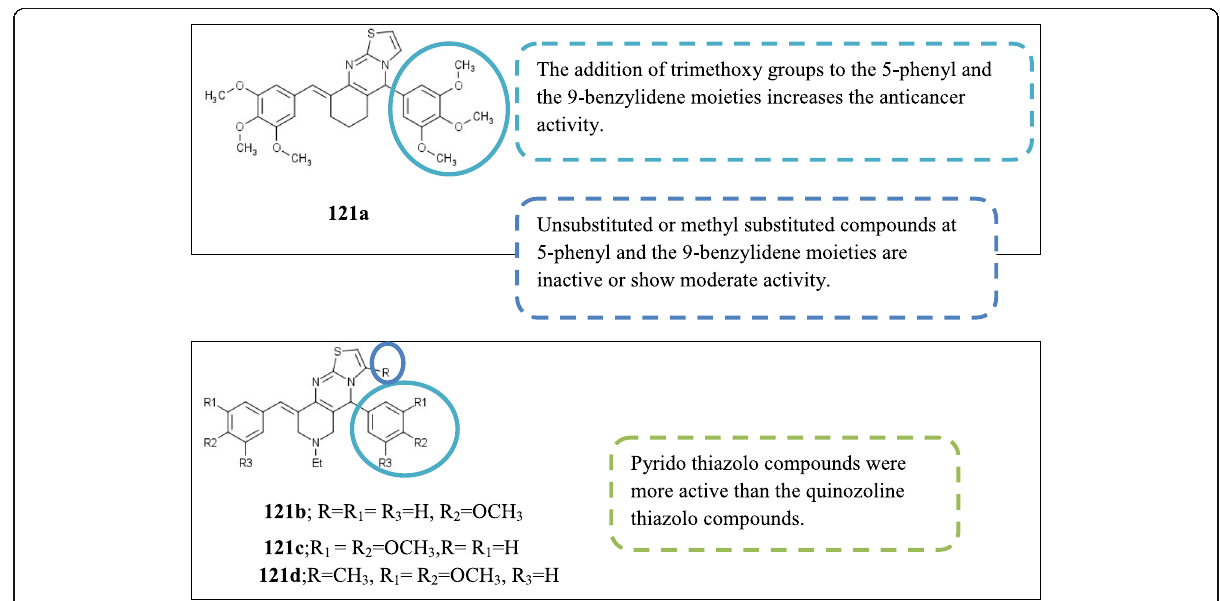
Fig. 38 Chemical structure and SAR studies of novel pyrido [4, 3-d] fused thiazolo [3,2-a]pyrimidine